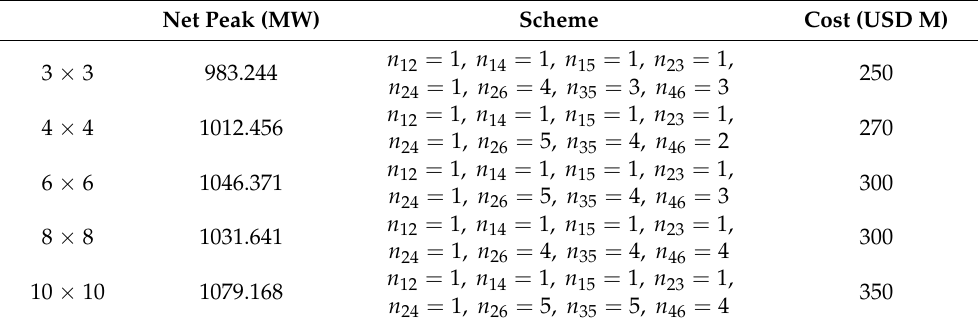
Table 5. Optimal results under the different number of